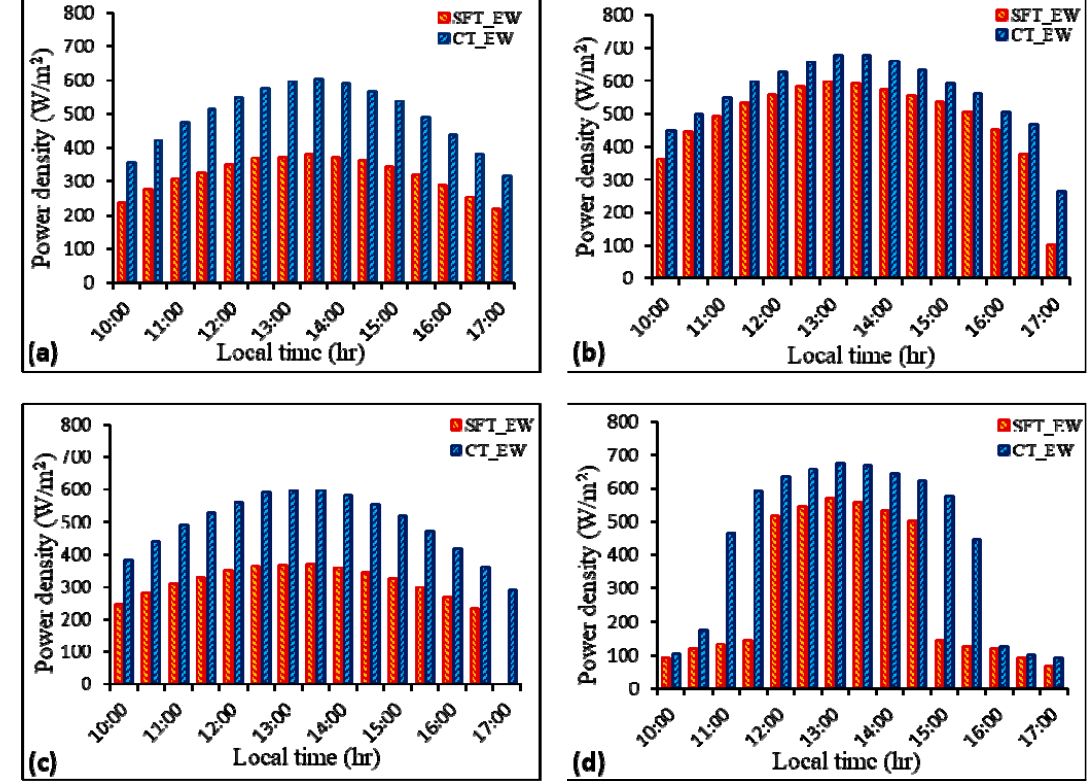
Figure 11. Available optical power density for E-W oriented CPC collector integrated with SFT and CT receivers at: ( a ) spring equinox (20th Mar); ( b ) summer solstice (21st Jun); ( c ) autumn equinox (23rd Sep) and ( d ) winter solstice (21st Dec).